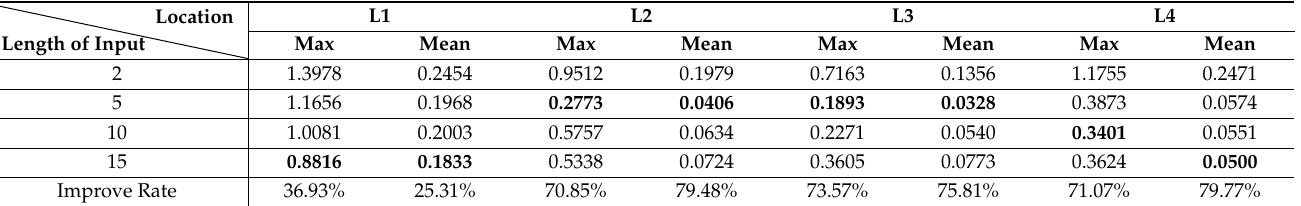
Table 3. AE ( ◦ C) variation of different input lengths at different positions, where the bold font is the minimum value of each